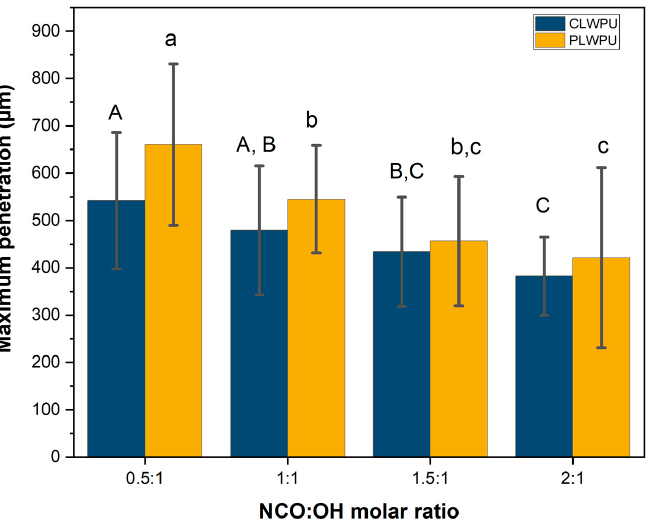
Figure 5. Maximum penetration of CLWPU and PLWPU adhesives in beech wood assemblies. The statistical differences between mean values at a 95% confidence interval ( p < 0.05) are indicated by different letters and were assessed by using one-way ANOVA and Tukey’s significant difference test.